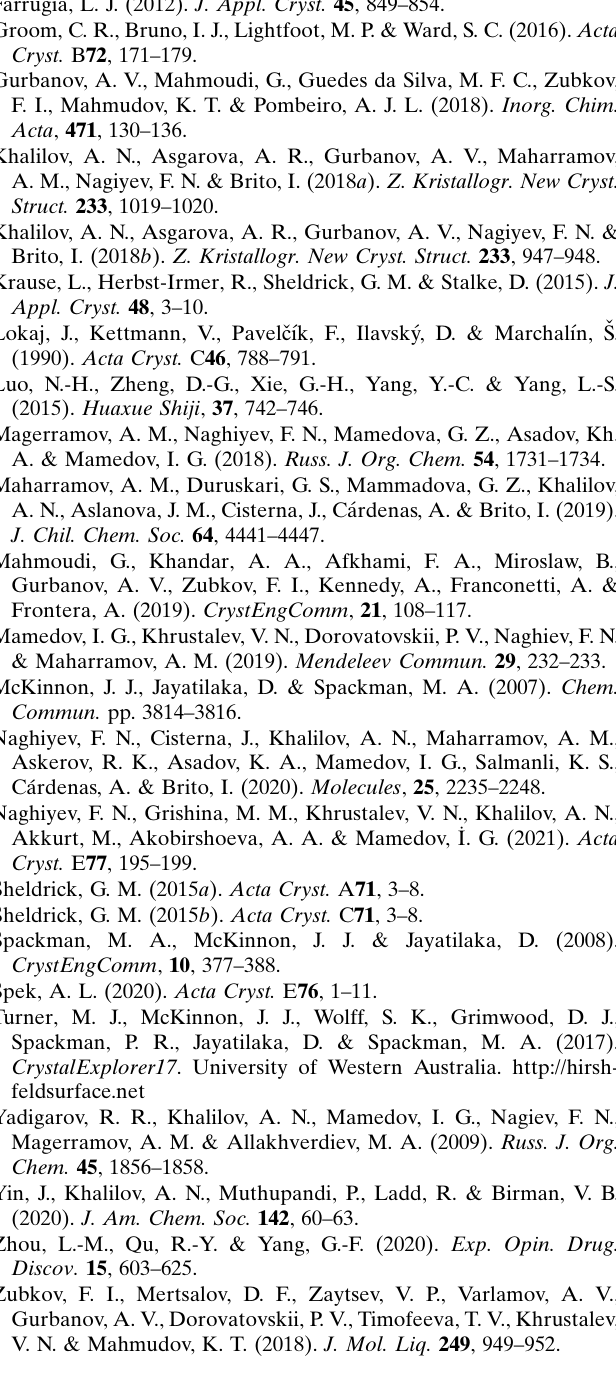
Table 3 Experimental details. Crystal data Chemical